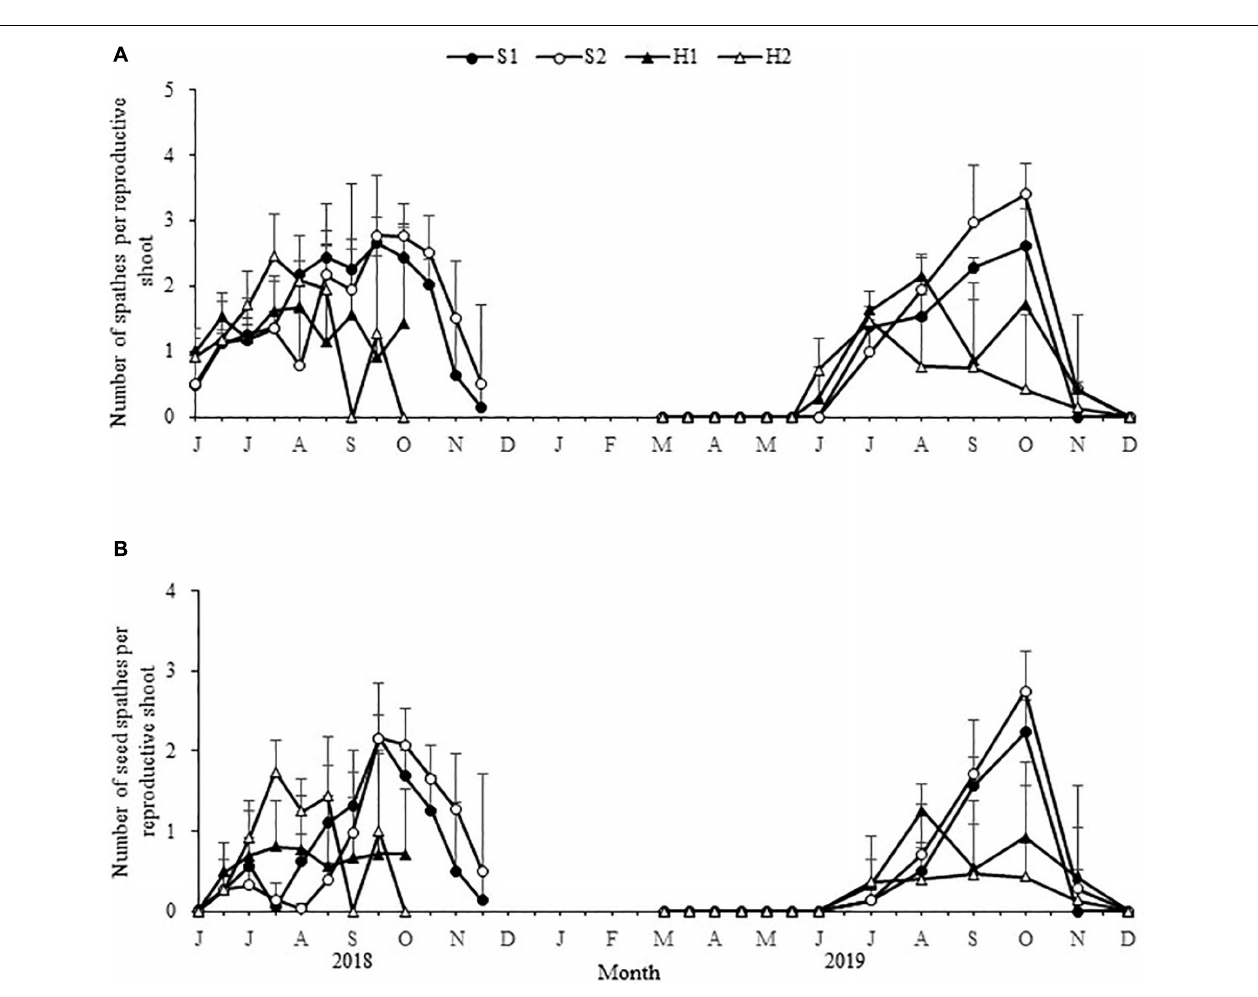
FIGURE 6 | Seasonal changes in the number of Zostera japonica spathes per reproductive shoot (A) , and the number of seed spathes per reproductive shoot (B) at the four study sites from June 2018 to December 2019. Values are mean ± SD ( N = 7 cores per site).